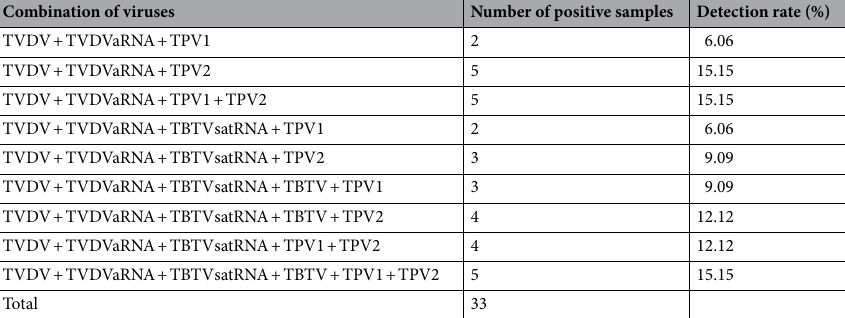
Table 7. RT-PCR detection of TPV1, TPV2 and the four TBTD causal viruses in 33 field collected tobacco samples.